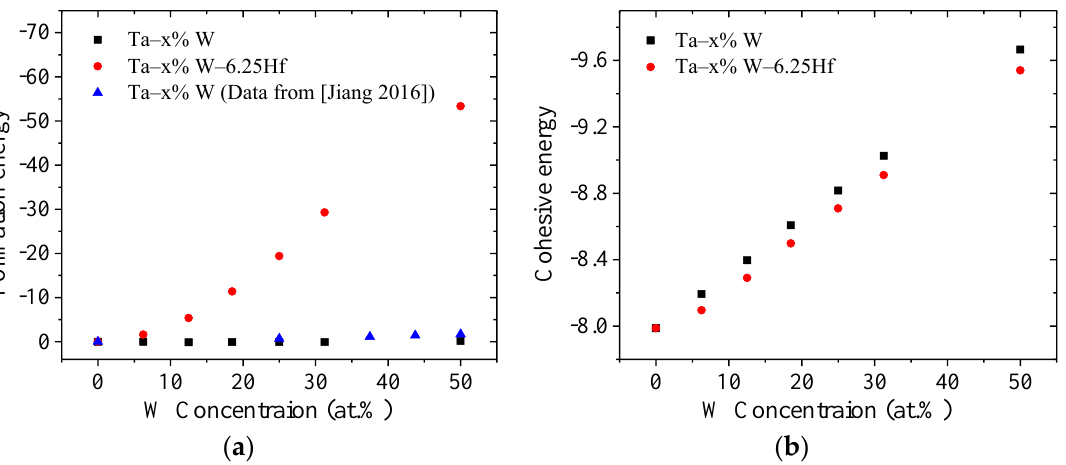
Figure 4. The formation energy and cohesive energy of Ta–W alloy and Ta–W–Hf alloy with different doping W contents: ( a ) the formation energy, ( b ) the cohesive energy. Data from Jiang [23].